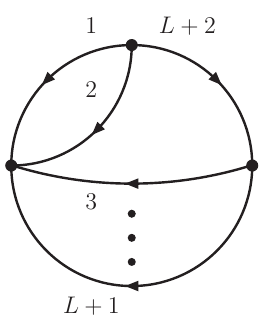
Figure 5 . The general form of the NMLT ( L ) topology.